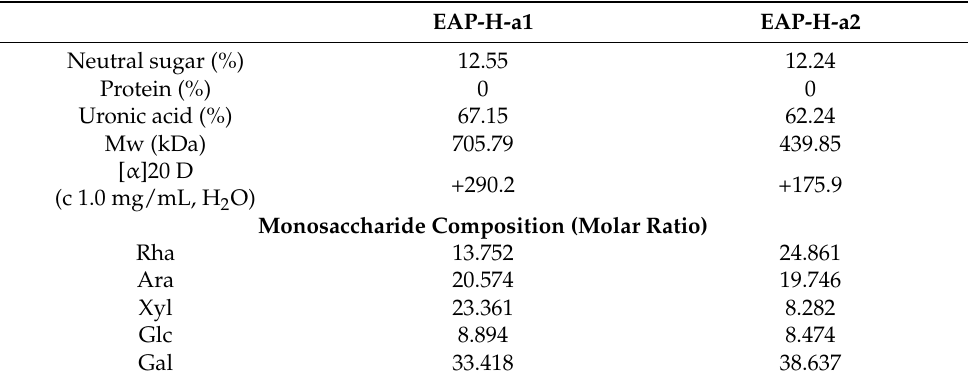
Table 1. Monosaccharide composition and contents of the purified fractions.